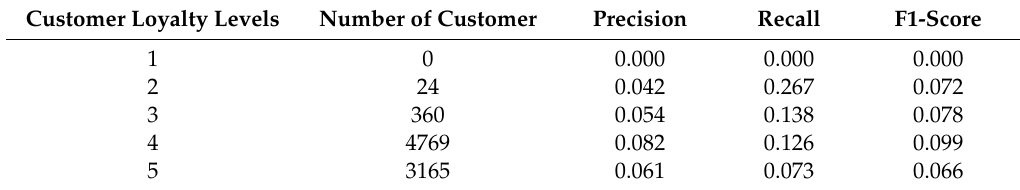
Table 5. Recommendation e ff ect of SVDW under di ff erent customer loyalty levels.